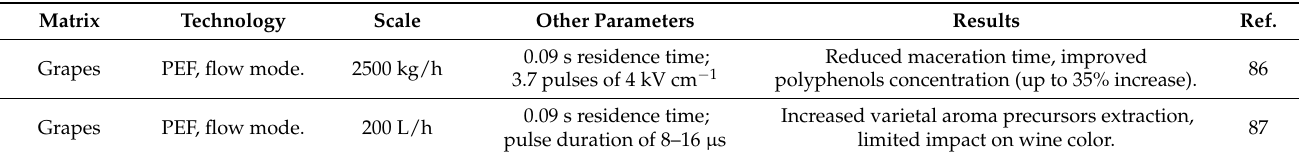
Table 4. Studies on pilot scale PEF, from 2017 to